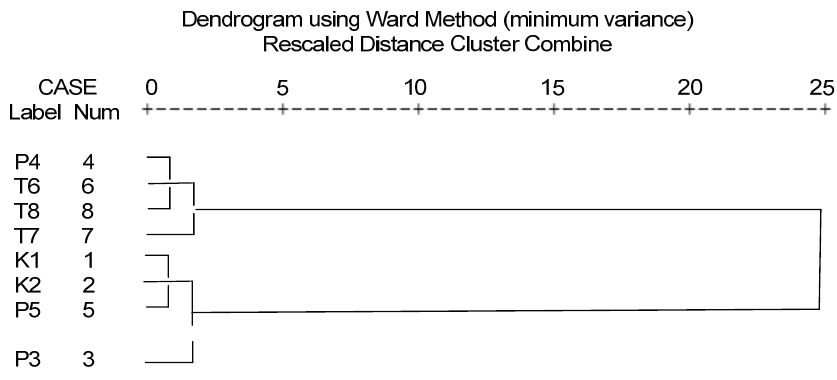
Figure 2. Dendrogram of hierarchical cluster analysis for the eight investigated batches of PSORI-CM01